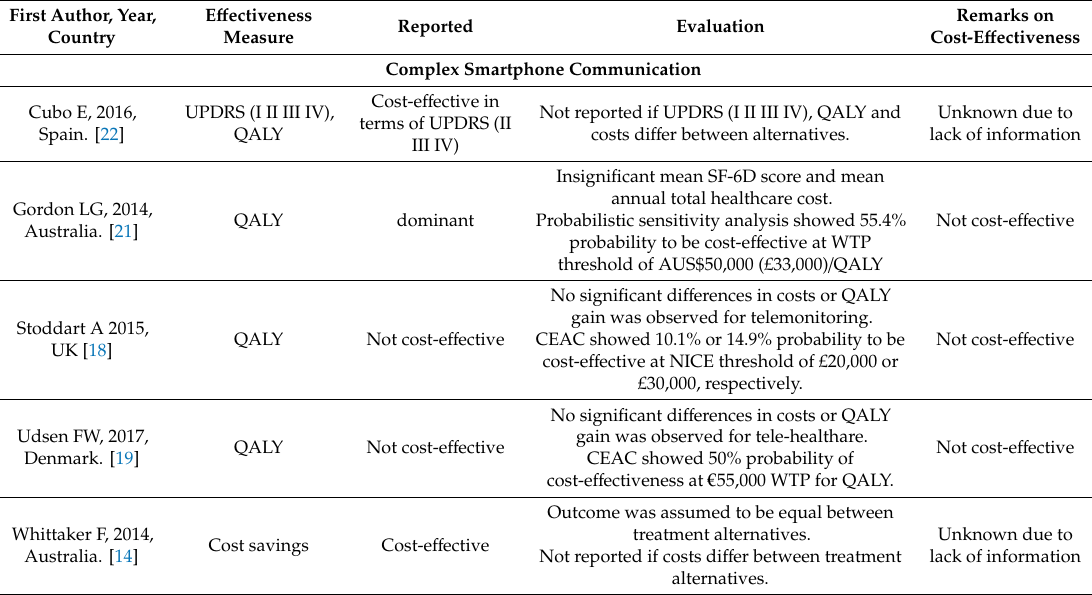
Table 1. Reported and evaluated cost-e ff ectiveness of the identified mHealth